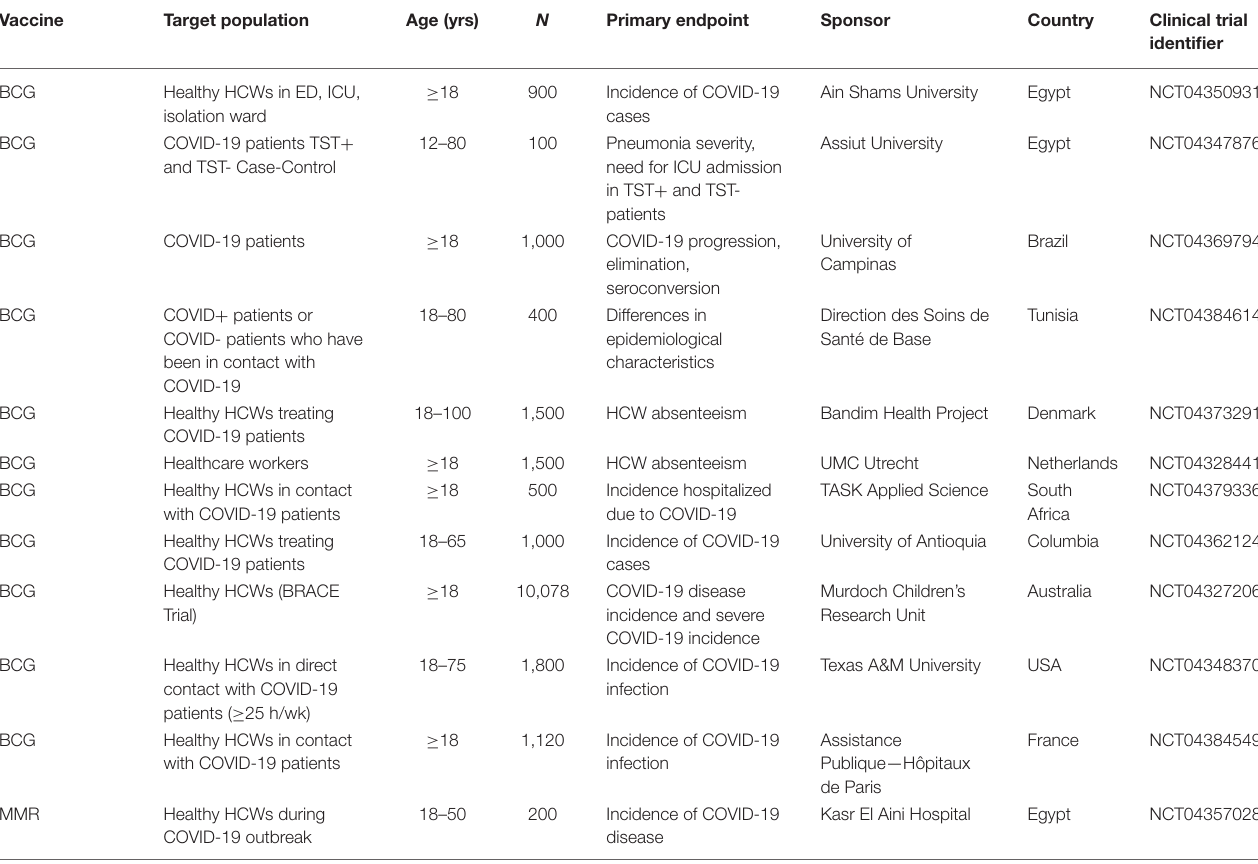
TABLE 3 | Clinical trials of BCG and MMR immunization for protection against COVID-19 (from clinicaltrials.gov).